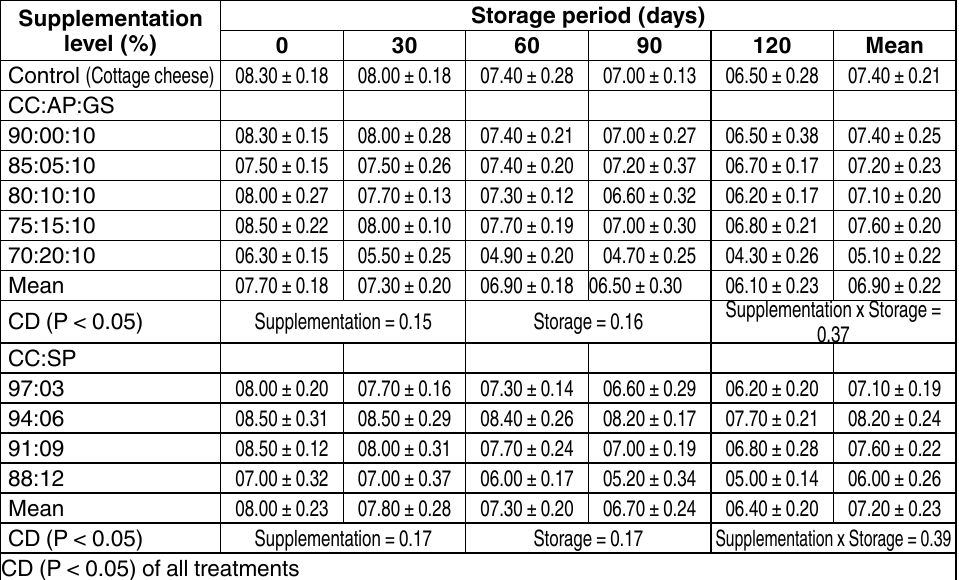
Table 2. Effect of supplementation and storage on appearance of value-added churpe products (balls and strips) Supplementation level